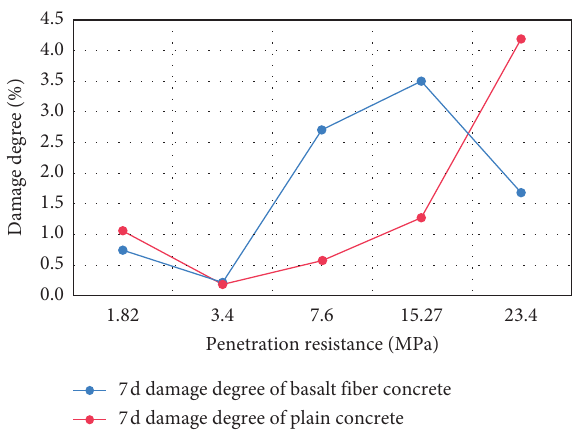
Figure 5: Damage degree of basalt fiber concrete and plain con- crete for 7d.